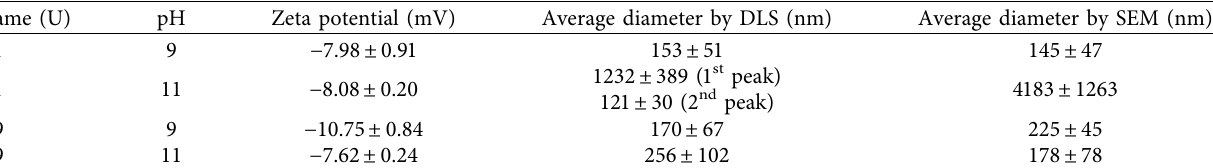
Table 1: Comparison of Ag NPs particle size by DLS and SEM (after drying).